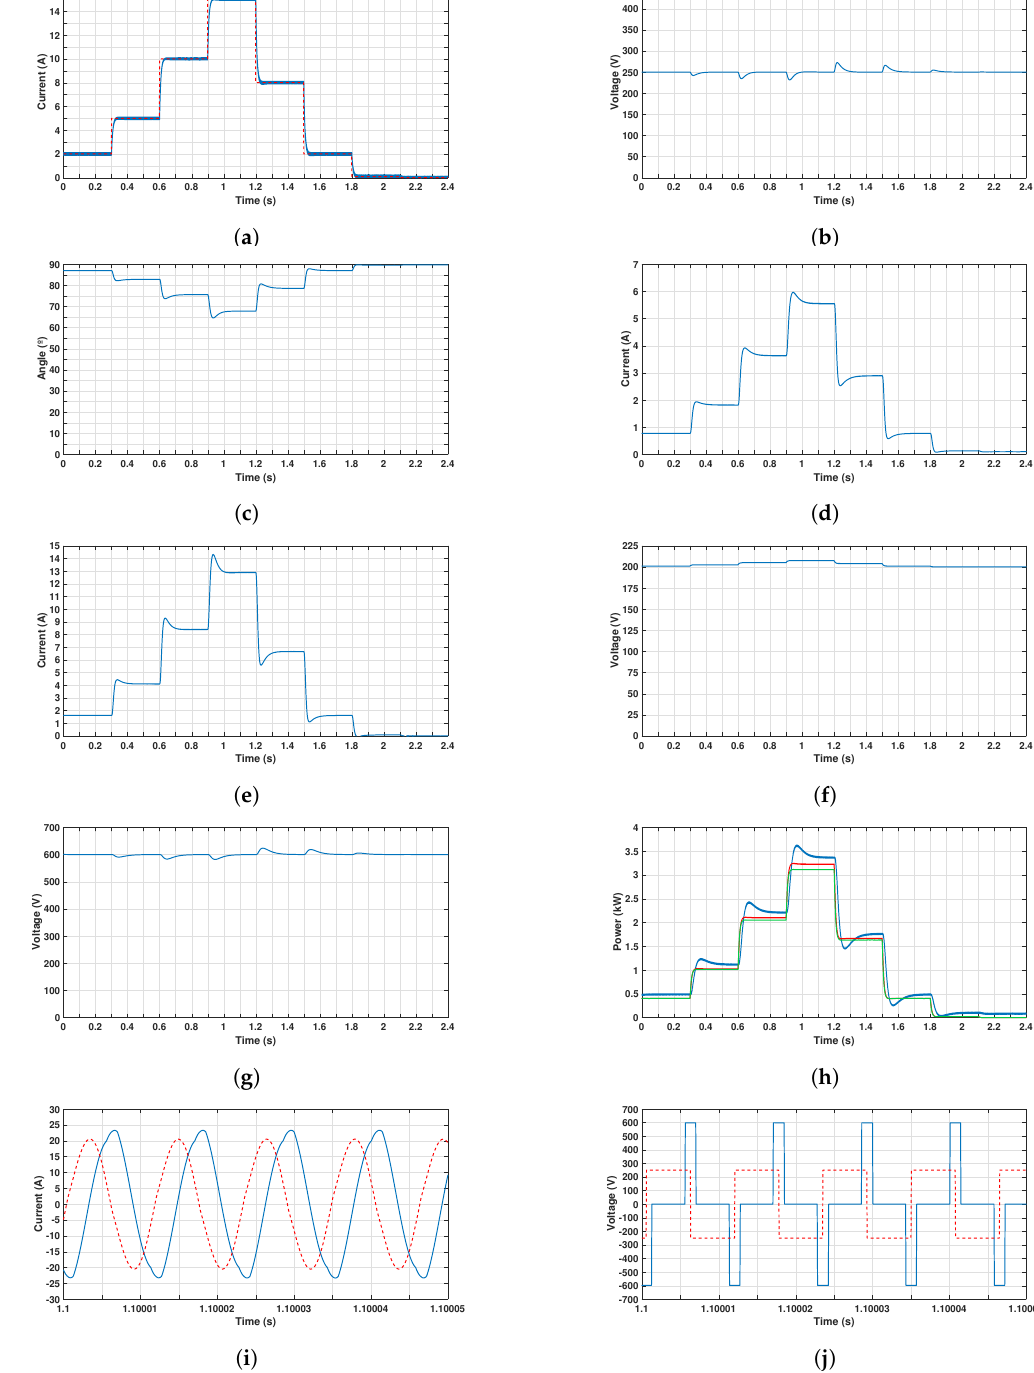
= 250 V. Time responses of: ( a ) the Figure 15. Results obtained for the G2V mode when k = 0.7 k n and v ∗ DC 2 battery current i b (blue) and the reference i ∗ (red); ( b ) the DC voltage v DC 2 ; ( c ) the phase-shift angle α ; b ( d ) the current i in ; ( e ) the current i 0 ; ( f ) the voltage of the battery v b ; ( g ) the DC voltage v DC 1 ; ( h ) the grid power P g (blue), the power at the input of the DC–DC converter P dc (red) and the battery power P b (green); ( i ) currents of the compensated magnetic coupler i 1 (blue), and i 2 (red); ( j ) voltages across the compensated magnetic coupler v 1 (blue), and v 2